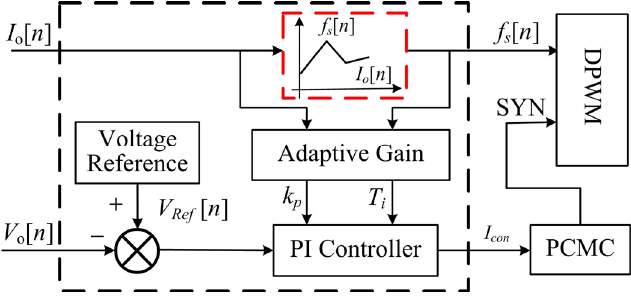
Figure 24. Control block diagram of the proposed